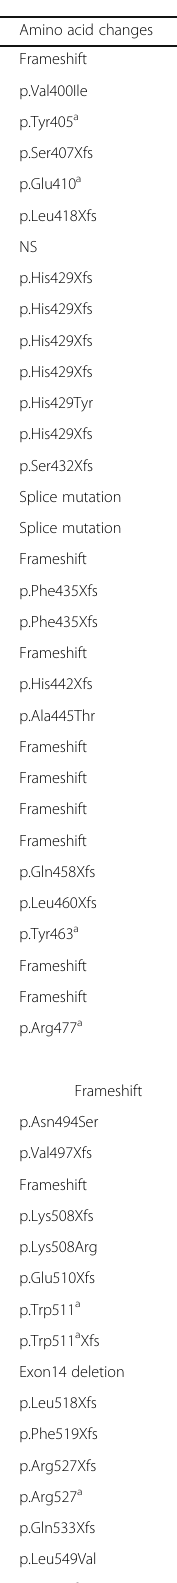
Table 1 Germline mutations in Birt-Hogg-Dubé syndrome